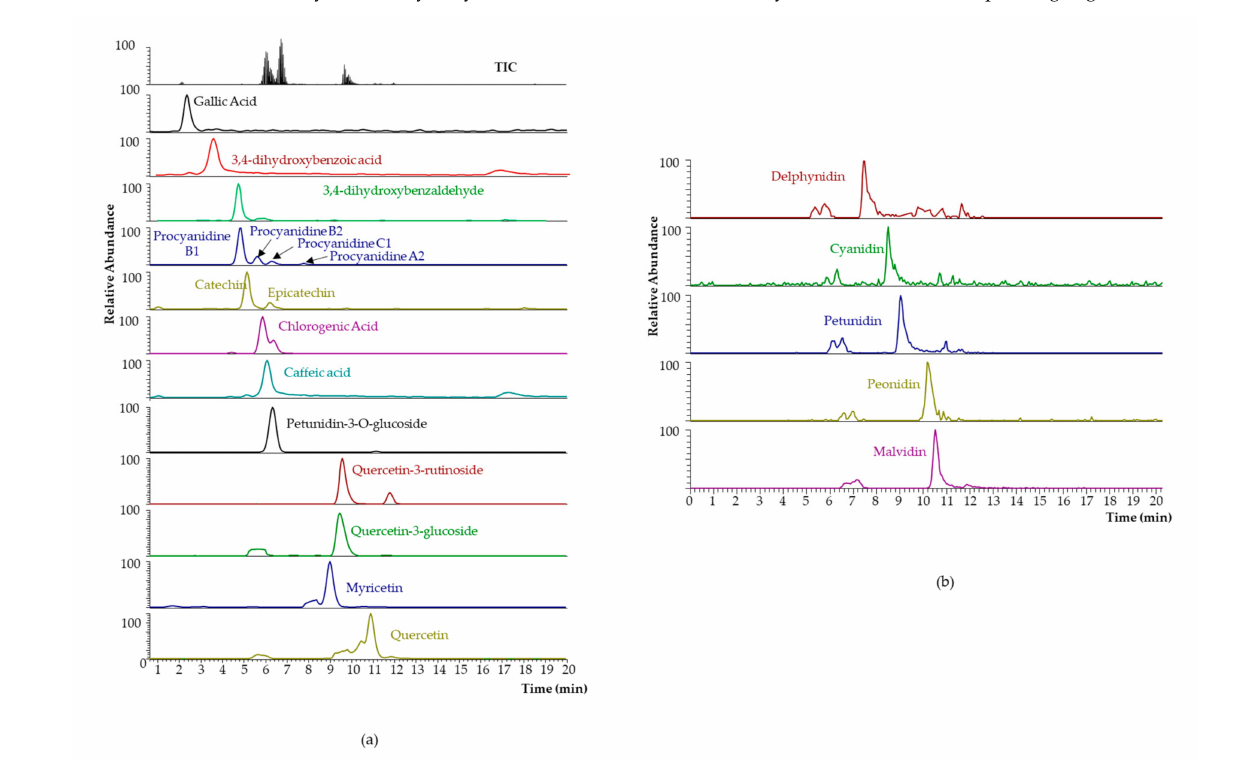
Figure 4. LC–MS/MS extracted chromatograms (see specific MS/MS transitions in Table S1) for the proof-of-concept VcB extract obtained at a pilot scale: ( a ) non-flavanoids, flavan-3-ols, procyanidins, flavonols, and anthocyanins; and ( b ) free anthocyanidins released by the alkaline hydrolysis of the extract (see concentrations in Table